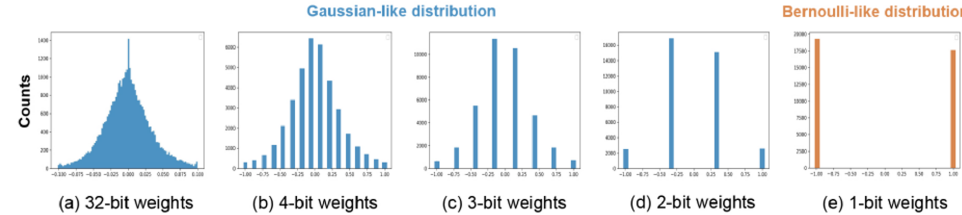
Figure 2. A visualization of weight quantization in a CNN. This figure shows different quantiza- tion